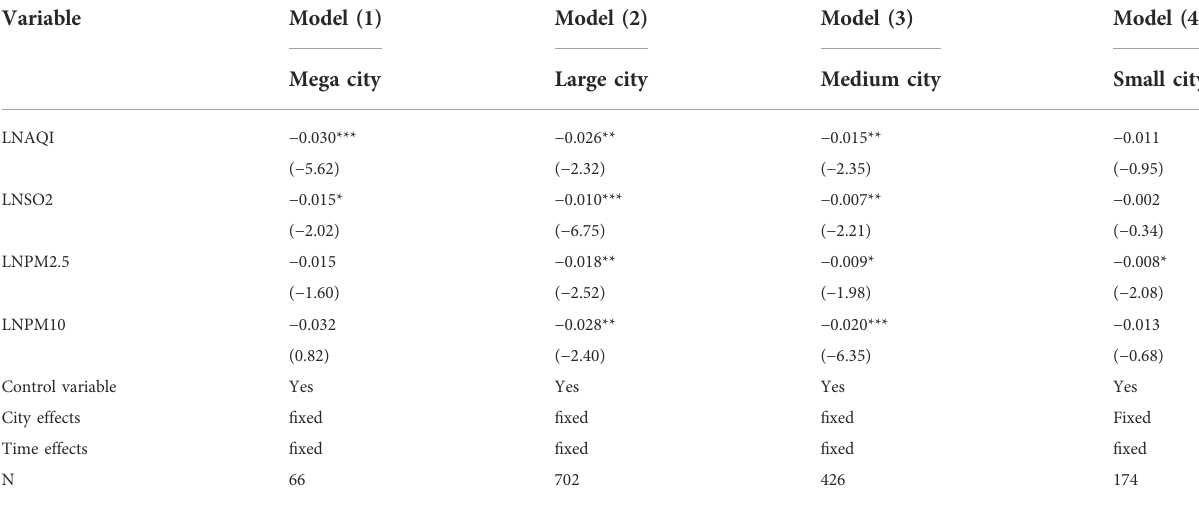
TABLE 6 Impact heterogeneity test under different city